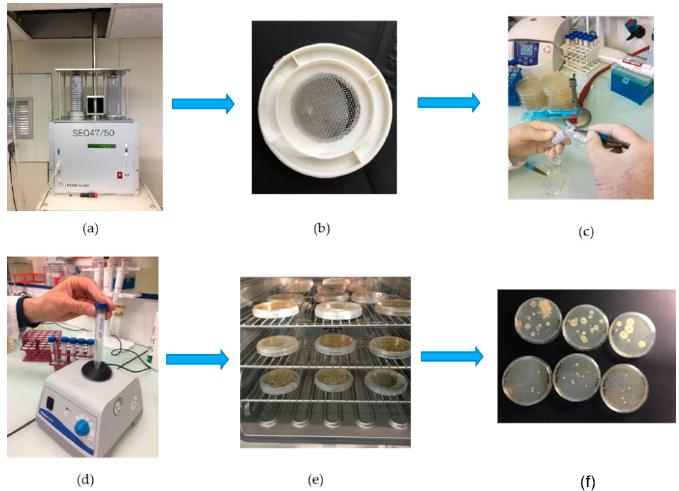
Figure 2. From atmospheric bacteria collection to cultivable counting: ( a , b ) sampling, ( c ) recovery of the filtrates in 3 mL of ultra-pure water, ( d ) extraction by stirring, ( e ) seeding on selective nutrient medium and incubation, ( f ) counting of colonies.